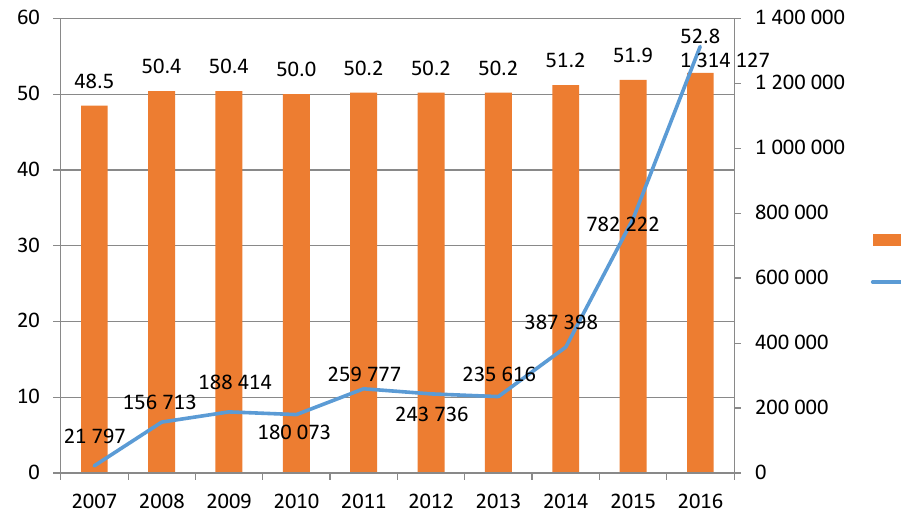
Figure 4. Declarations submitted (right axis) and employment rate (left axis) in Poland, 2007–2016